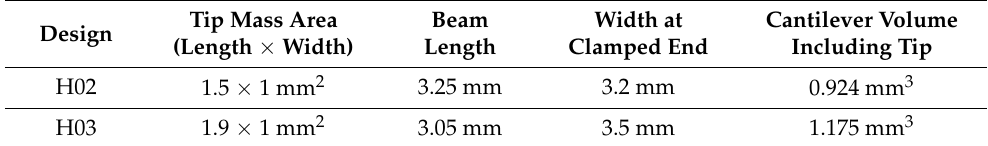
Figure 3. Photograph of the two MEMS designs used for the wakeup scheme. Micromagnets made of NdFeB powder are wafer-level integrated into the cantilever tips (black squares). Refer to Table 1 for dimensions. Table 1. Basic design parameters of the MEMS harvesters.